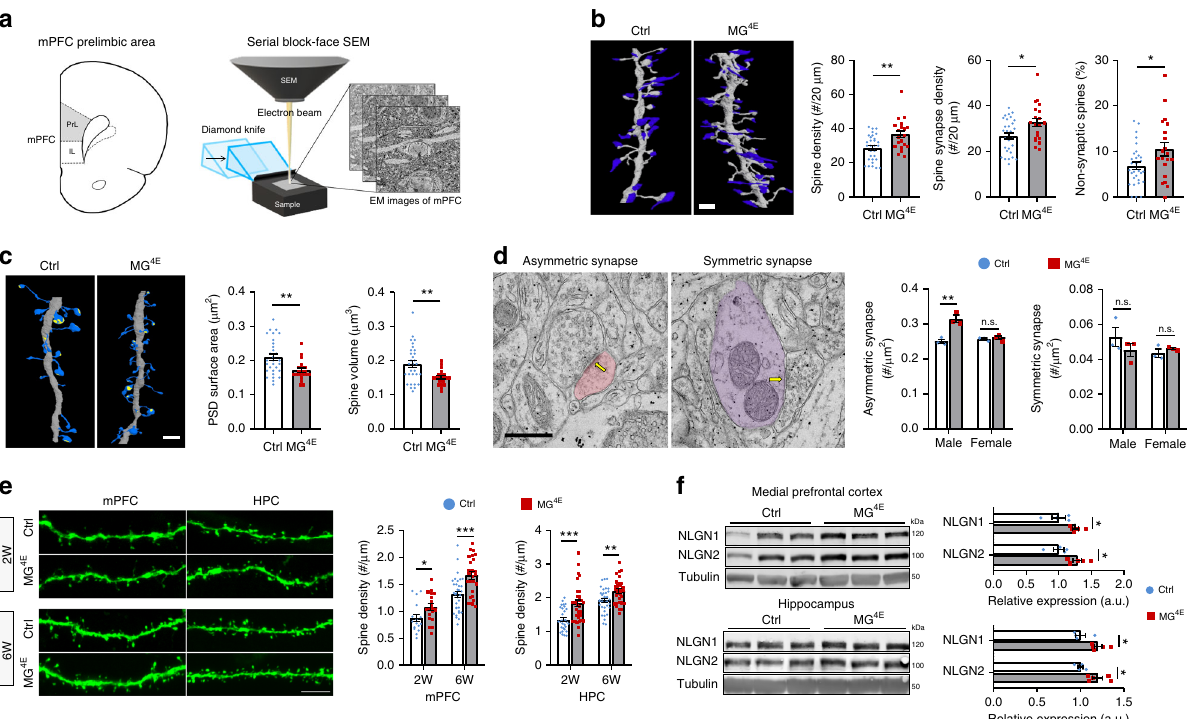
Fig. 5 Structural and functional alterations in synapses of MG 4E mice. a Schematic diagram of mPFC serial block-face scanning electron microscopy (SB- SEM). b Spine density in the mPFC of 6-week-old male control and MG 4E mice. Representative dendrites reconstructed from SB-SEM images show dendritic spines (gray) and presynaptic terminals (blue). Graphs show spine density, synaptic spine density and percentage of non-synaptic spines. 5 control mice, 40 dendrites and 1187 spines; 6 MG 4E mice, 30 dendrites and 1120 spines. Two-sided t -test (spine density, ** p = 0.0017; synaptic spine density, * p = 0.0112; non-synaptic spine * p = 0.0253). Scale bar, 2 µ m. c Spine volume and synaptic size. Representative dendrites reconstructed from SB- SEM images show dendritic spines (blue) and postsynaptic density (PSD, light yellow). Graphs show PSD size and spine volume. 5 control mice, 40 dendrites and 1098 spines; 6 MG 4E mice, 30 dendrites and 999 spines. Two-sided t test (PSD area, ** p = 0.0044; spine volume, ** p = 0.0037). Scale bar, 2 µ m. d Density of asymmetric and symmetric synapses in the mPFC of 6-week-old male and female control and MG 4E mice. Images show representative asymmetric and symmetric synapses (arrows). n = 3 mice and 30 images per mouse for each group. ** p = 0.0059 by two-sided t -test. Scale bar, 2 µ m. e Spine density in mPFC layer 5 neurons and hippocampal CA1 neurons of 2-week-old (2 W) and 6-week-old (6 W) male control and MG 4E mice. 2 W, 6 mice per genotype; 6 W, 6 control mice and 7 MG 4E mice; 2 – 5 neurons in each brain region per mouse. * p = 0.0362, ** p = 0.0012 and *** p < 0.001 by two-sided t -test. Scale bar, 5 µ m. f Levels of neuroligin 1 (NLGN1) and neuroligin 2 (NLGN2) in the mPFC and hippocampus. n = 4 control mice and 5 MG 4E mice. Two-sided t test (mPFC, * p = 0.0409 for NLGN1 and * p = 0.0279 for NLGN2; hippocampus, * p = 0.0207 for NLGN1 and * p = 0.0229 for NLGN2). All data are shown as mean ± s.e.m. Source data are provided as a Source Data fi